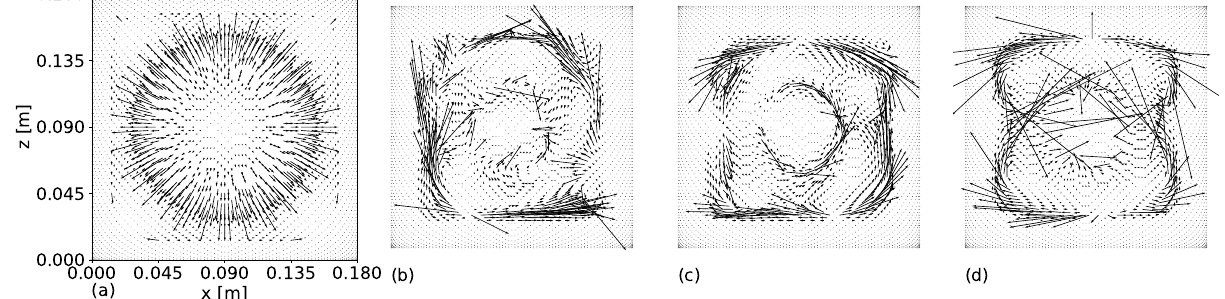
Figure 13. Velocity vectors at HA1. ( a ) k − ε model; steady-state; ( b ) LES model at t 1 = 205 s; ( c ) LES model at t 2 = 1096 s; ( d ) LES model; time-average.